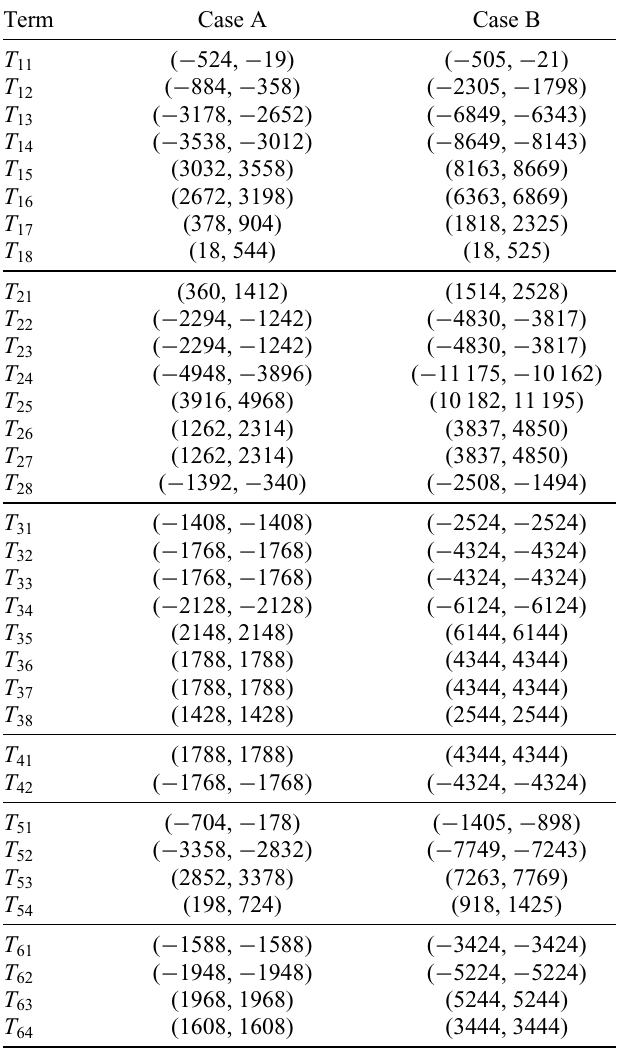
TABLE I. Minimum and maximum values of various reso- nance conditions for both trapping parameters, viz. case A and case B. The frequencies are reported in units of